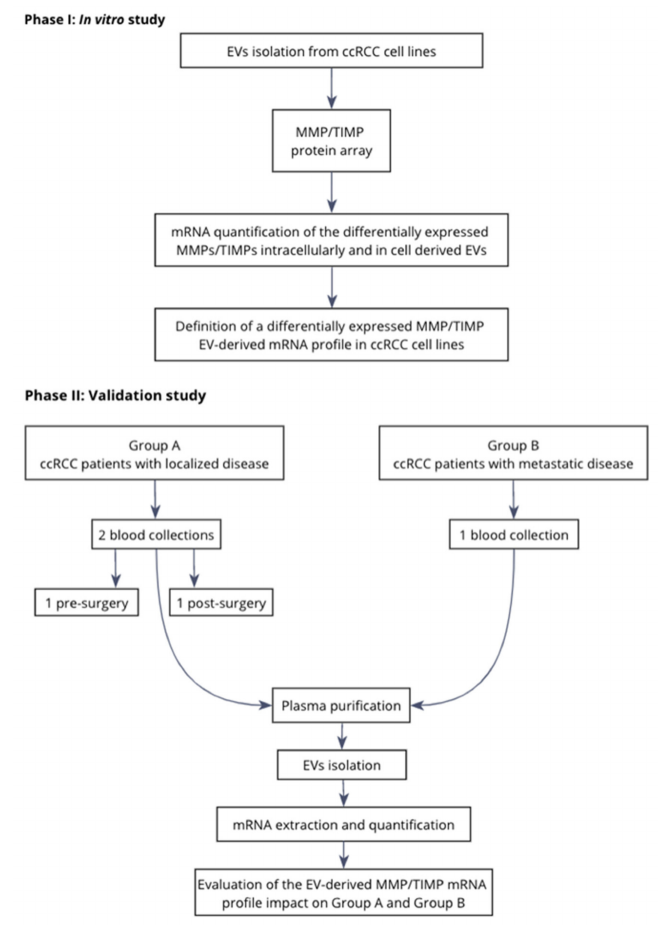
Figure 5. Study design flow